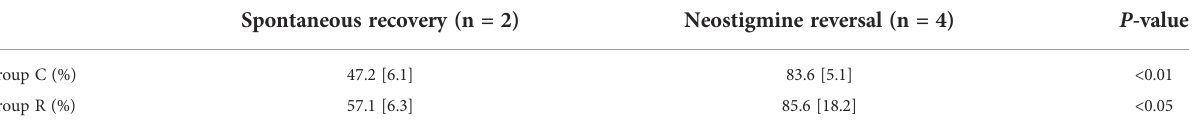
TABLE 2 Maximum EMG amplitude recovery.